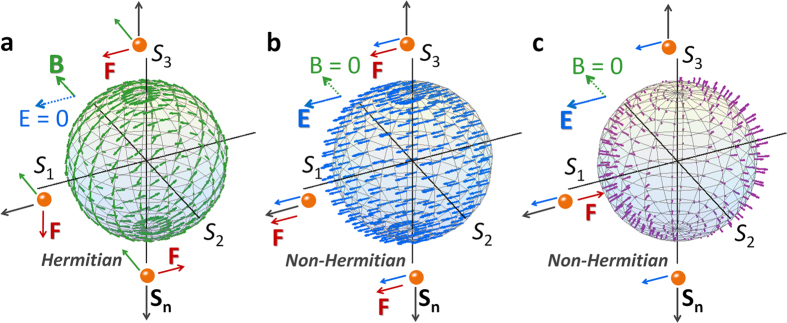
Lorentz pseudo-forces for the acceleration of optical SOP.Classical (a) magnetic (Sn×B) and (b) electric accelerations (E) on the Poincaré sphere. (c) The acceleration from the relativistic energy variation (−Sn(Sn·E)), originating from the PT-symmetric pseudo-Hermiticity of the Hamiltonian Hs. The corresponding forces F (red arrows) for accelerating positively-charged pseudo-particles (orange spheres) with different pseudo-velocities (or different SOPs, black arrows of Sn) are also shown in (a–c), for Sn = e1, e3, and −e3.